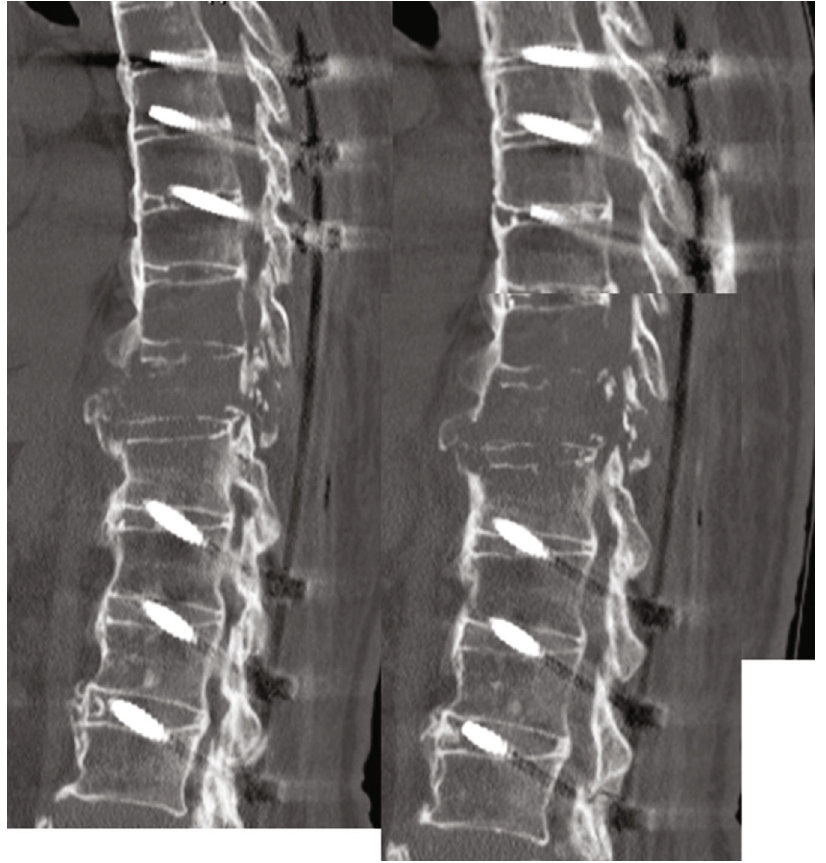
Figure 5: Postoperative CT showing appropriate implant placement and satisfactorily strong